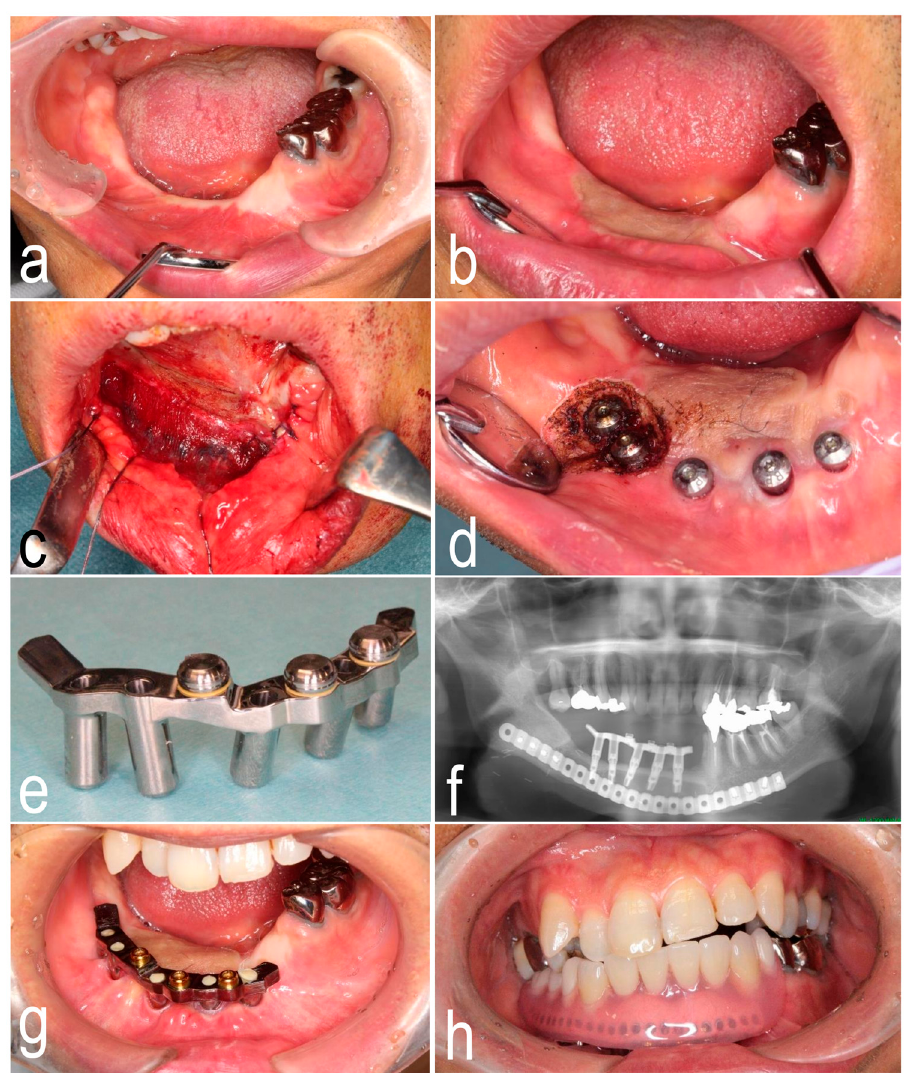
(Figure 1f–h). Eighteen months after implant placement, no hyperplastic / inflammatory response and formation of the granulomatous tissue around implants were found. Dent. J. 2019 , 7 , x FOR PEER REVIEW